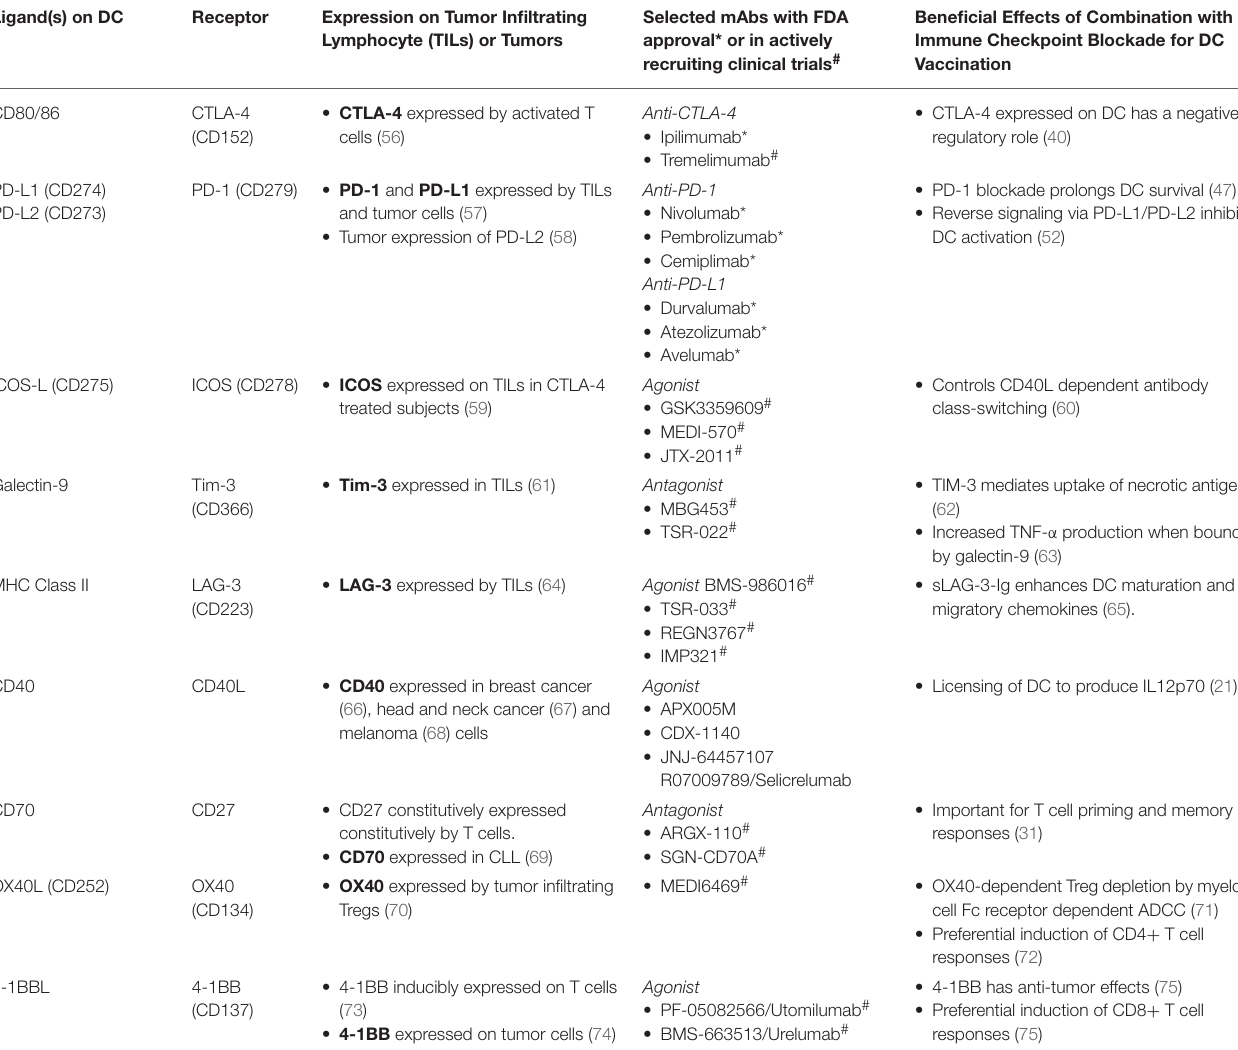
TABLE 1 | Dendritic cell, T cell and tumor-associated expression of B7/CD28 and TNFR superfamily ligands and receptors. Ligand(s) on